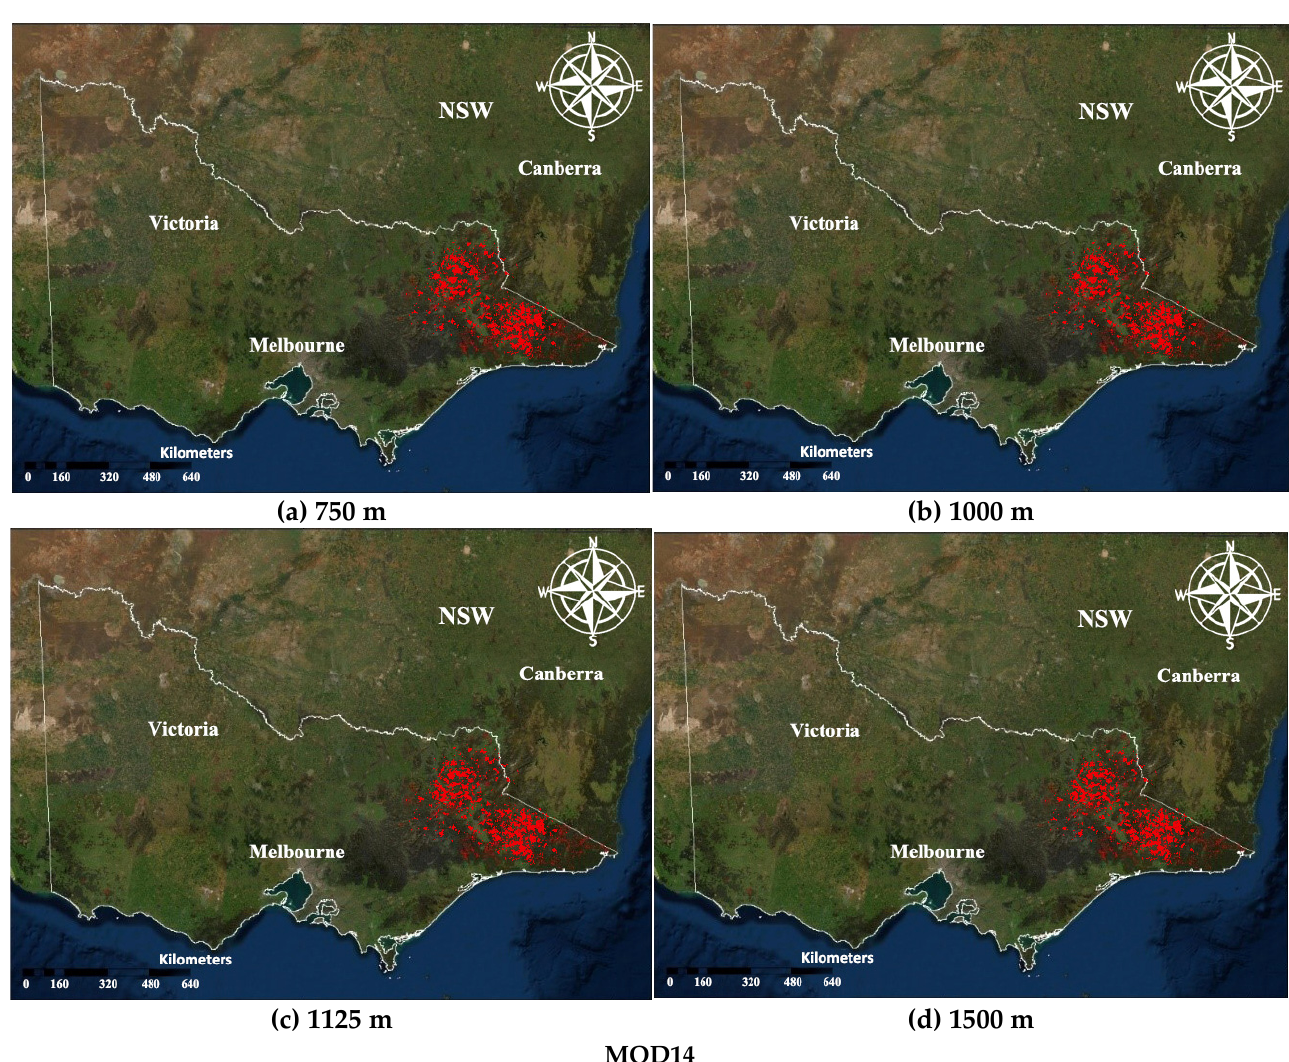
Figure 10. Aggregate perimeters identified from the MOD14 active fire products using the distances of (a) 750 m, (b) 1000 m, (c) 1125 m, (d) 1500 m.